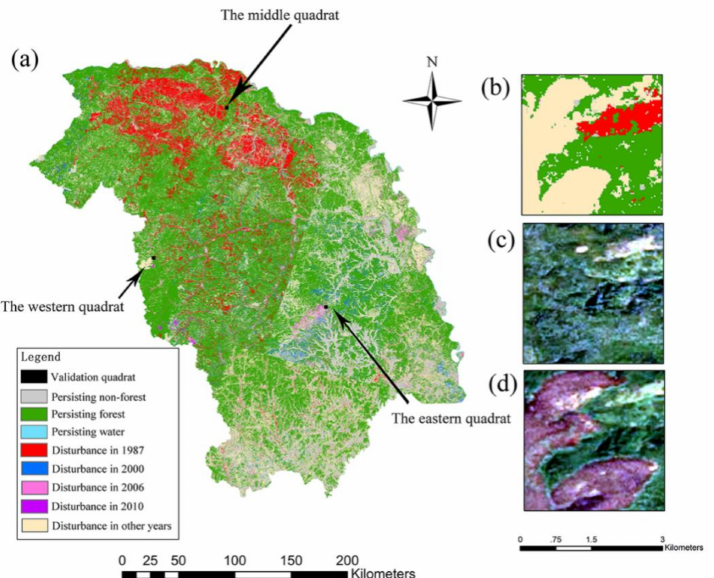
Figure 2. ( a ) Forest disturbance patterns obtained from the VCT algorithm in the study area, including persisting forest, persisting non-forest, persisting water, and forest disturbance in different years; ( b ) annual forest disturbance patterns of the western quadrat; ( c ) Landsat image of the western quadrat before the disturbance in 1986; ( d ) Landsat image of the western quadrat after the disturbance in